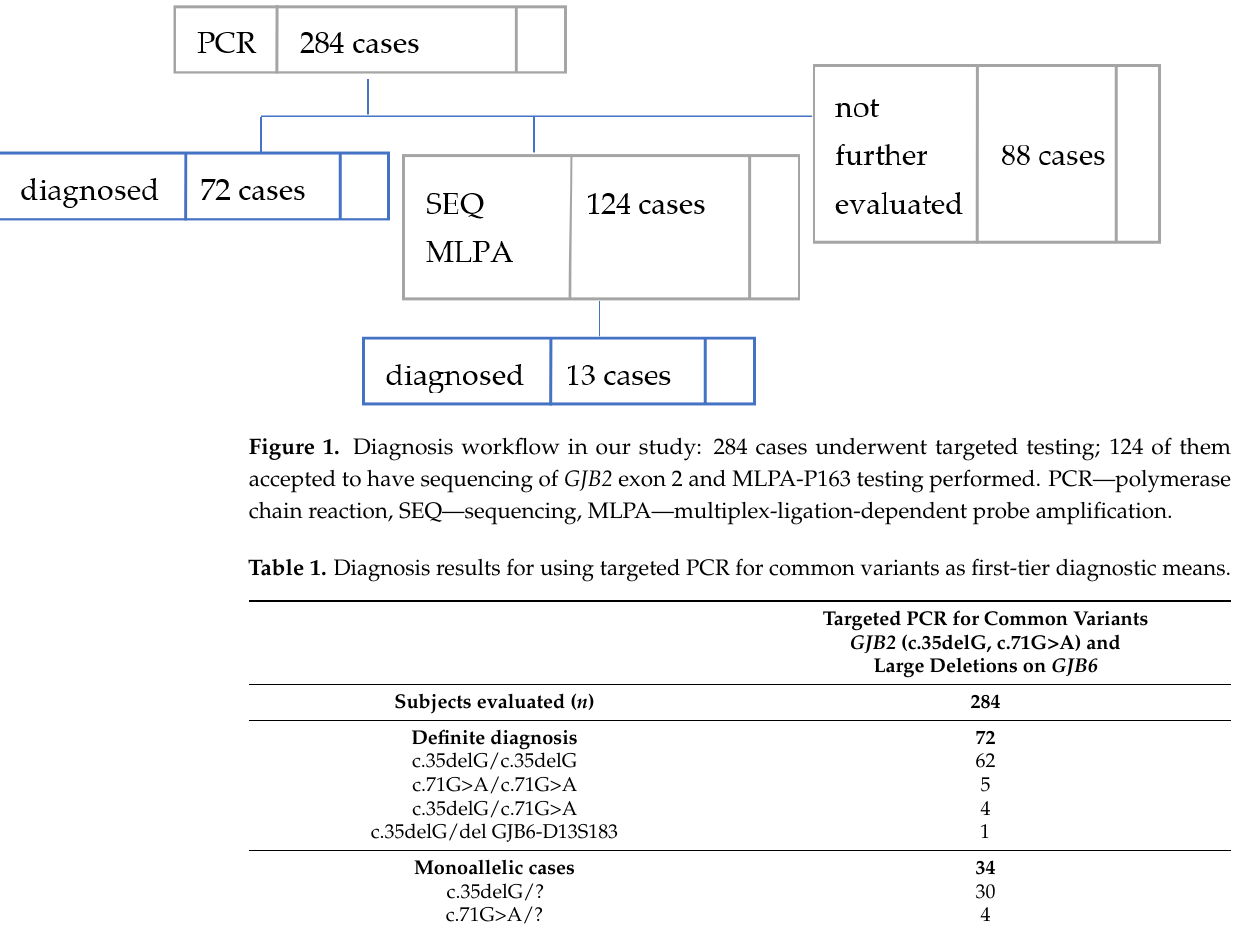
Table 1. Diagnosis results for using targeted PCR for common variants as first-tier diagnostic means.